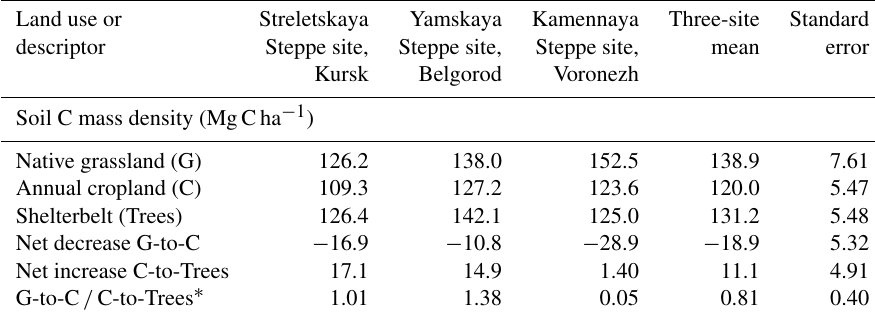
Table 2. Soil organic carbon storages and differences within the 0 to 30cm depth increment under three land uses (i.e., native grasslands, annual croplands, and afforestation) in Russia. The nine values of soil C storage across the nine site/land uses were previously presented and discussed in Chendev et al. (2015b) and are repeated here for informing first-order kinetic modeling and estimations of C accretion rates when converting from annual croplands to afforestation as shown in Fig. 3. At the time of soil sample collection, the ages of the annual croplands in Streletskaya and Yamskaya were at least 140 years and at least 145 years of age in Kamennaya. In all three sites, the shelterbelts had been planted 55 years prior to soil sample